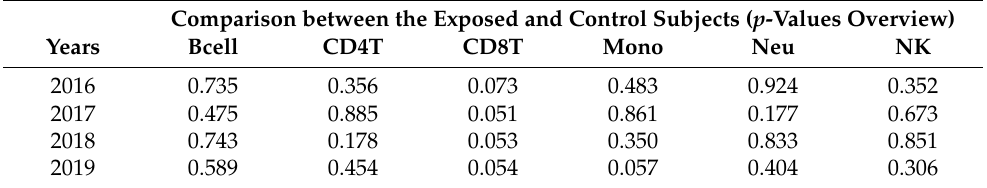
Table A1. Blood cell types comparisons ( p -values) of the exposed and control subjects for individual years (2016–2019). Comparison between the Exposed and Control Subjects ( p -Values